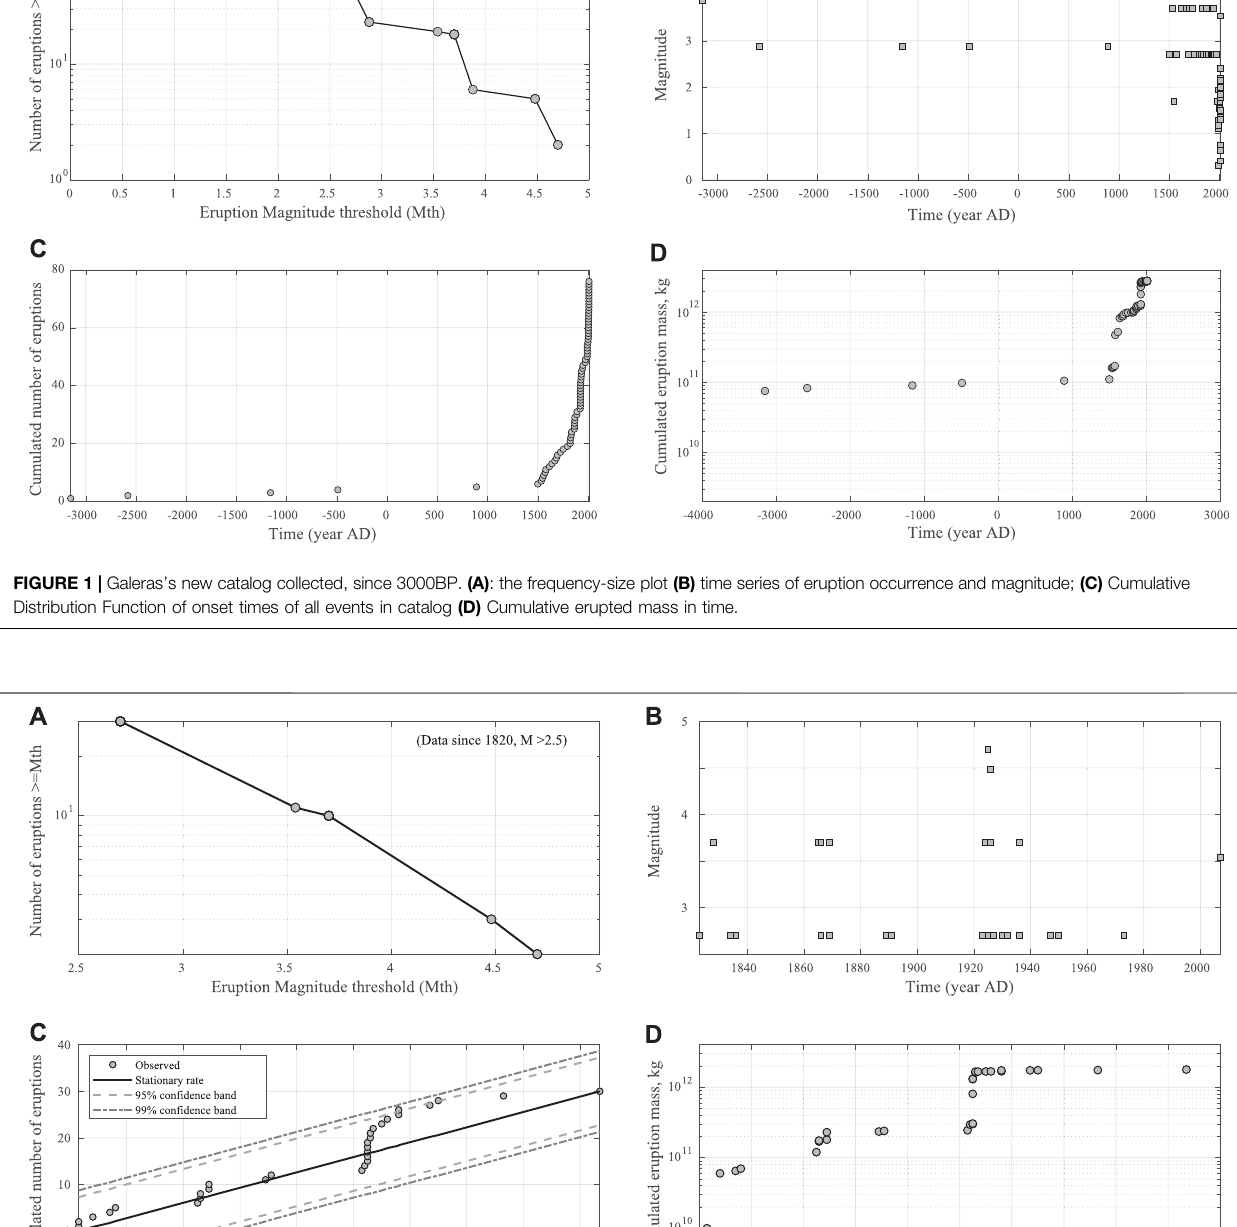
Frontiers in Earth Science |